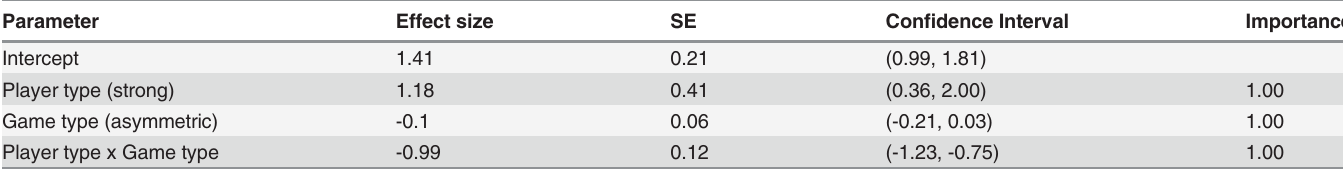
Table 4. Effect sizes, unconditional standard errors, con fi dence intervals and relative importance for parameters included in the top models for the binary response term encoding whether or not players cooperated in each round of the game (player defected = 0, player cooperated = 1).